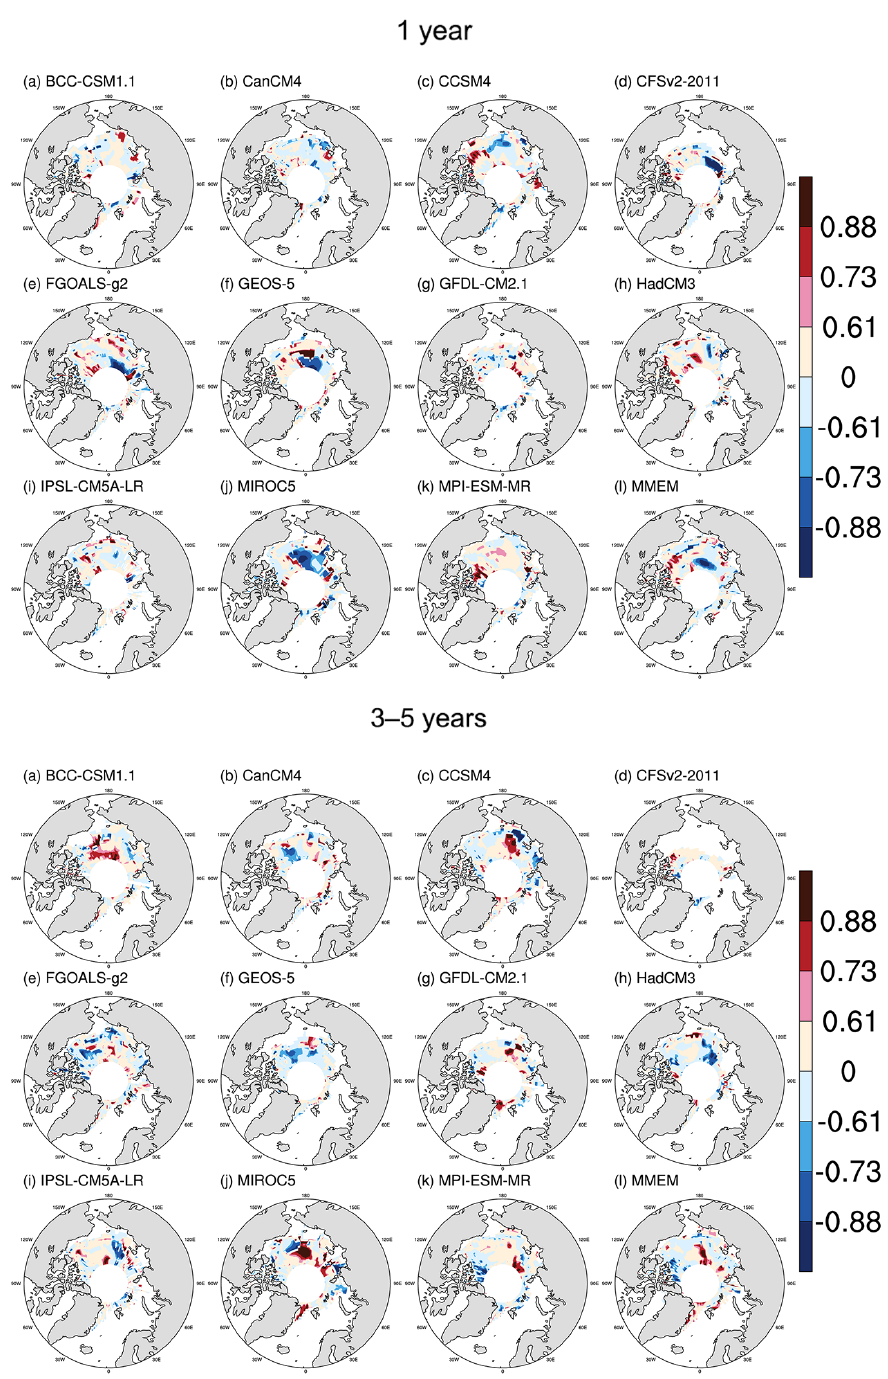
Figure 5. Same as Fig. 3, but for detrended September sea ice concentration